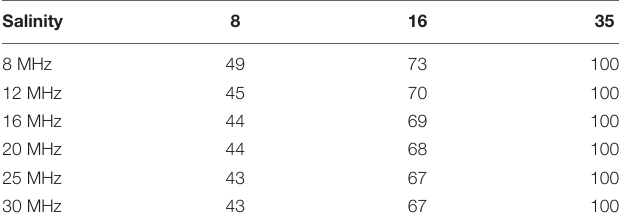
TABLE 4 | Variation of the HF radar range on salinity in percent, for typical transmit